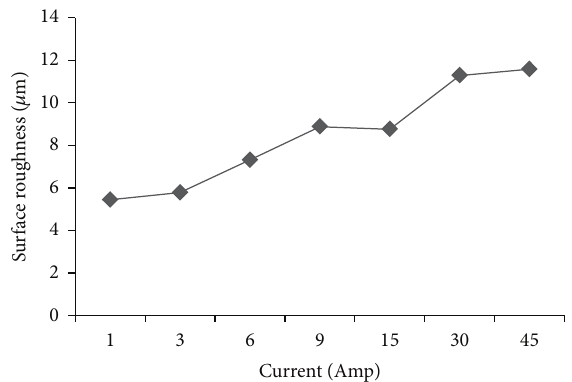
Figure 17: Influence of current on SR at constant gap voltage 60 V, pulse-on time 90 𝜇 s, and pulse-off time 90 𝜇 s.